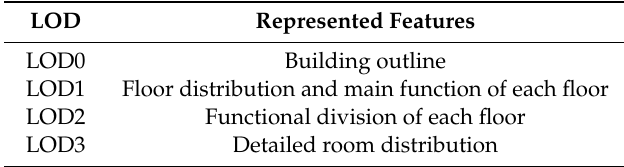
Table 2. LOD specifications for building structures.